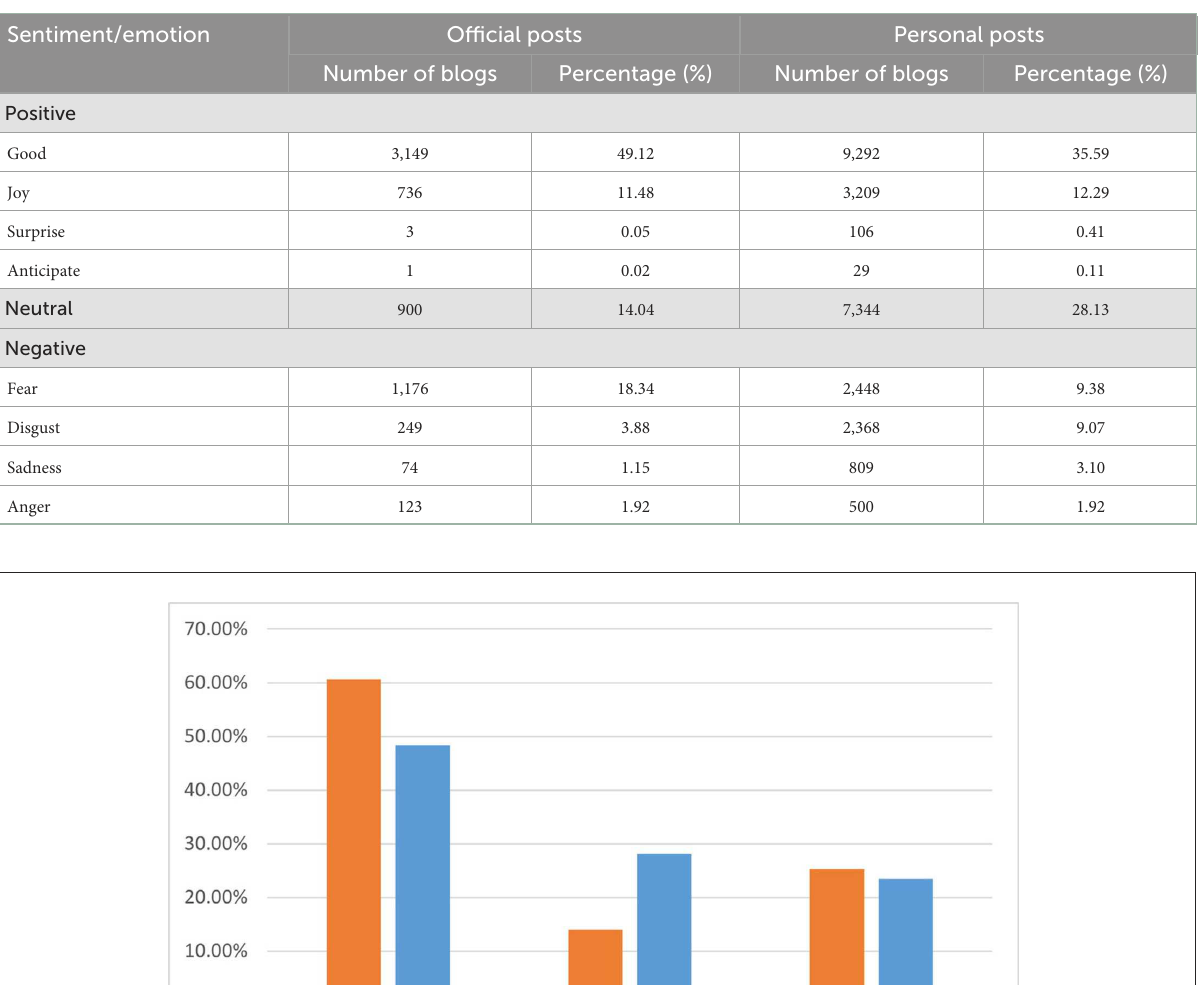
TABLE 4 Sentiment and emotion distribution of official Weibo and personal Weibo.